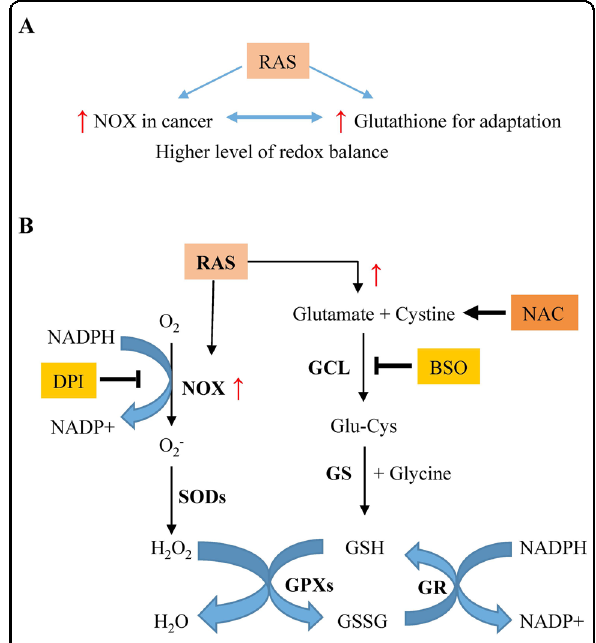
Fig. 7 Targeted inhibition of NOX activation and glutathione biosynthesis for treating mutant RAS -harboring cancers. A Oncogenic RAS activation enhances both ROS-generating NOX and ROS-scavenging glutathione biosynthesis to induce a higher level of redox balance for optimal survival and proliferation of cancer cells. B NOX catalyzes the oxidation of NADPH to NADP + , leading to the generation of O 2 − by the reduction of molecule oxygen (O 2 ). O 2 −